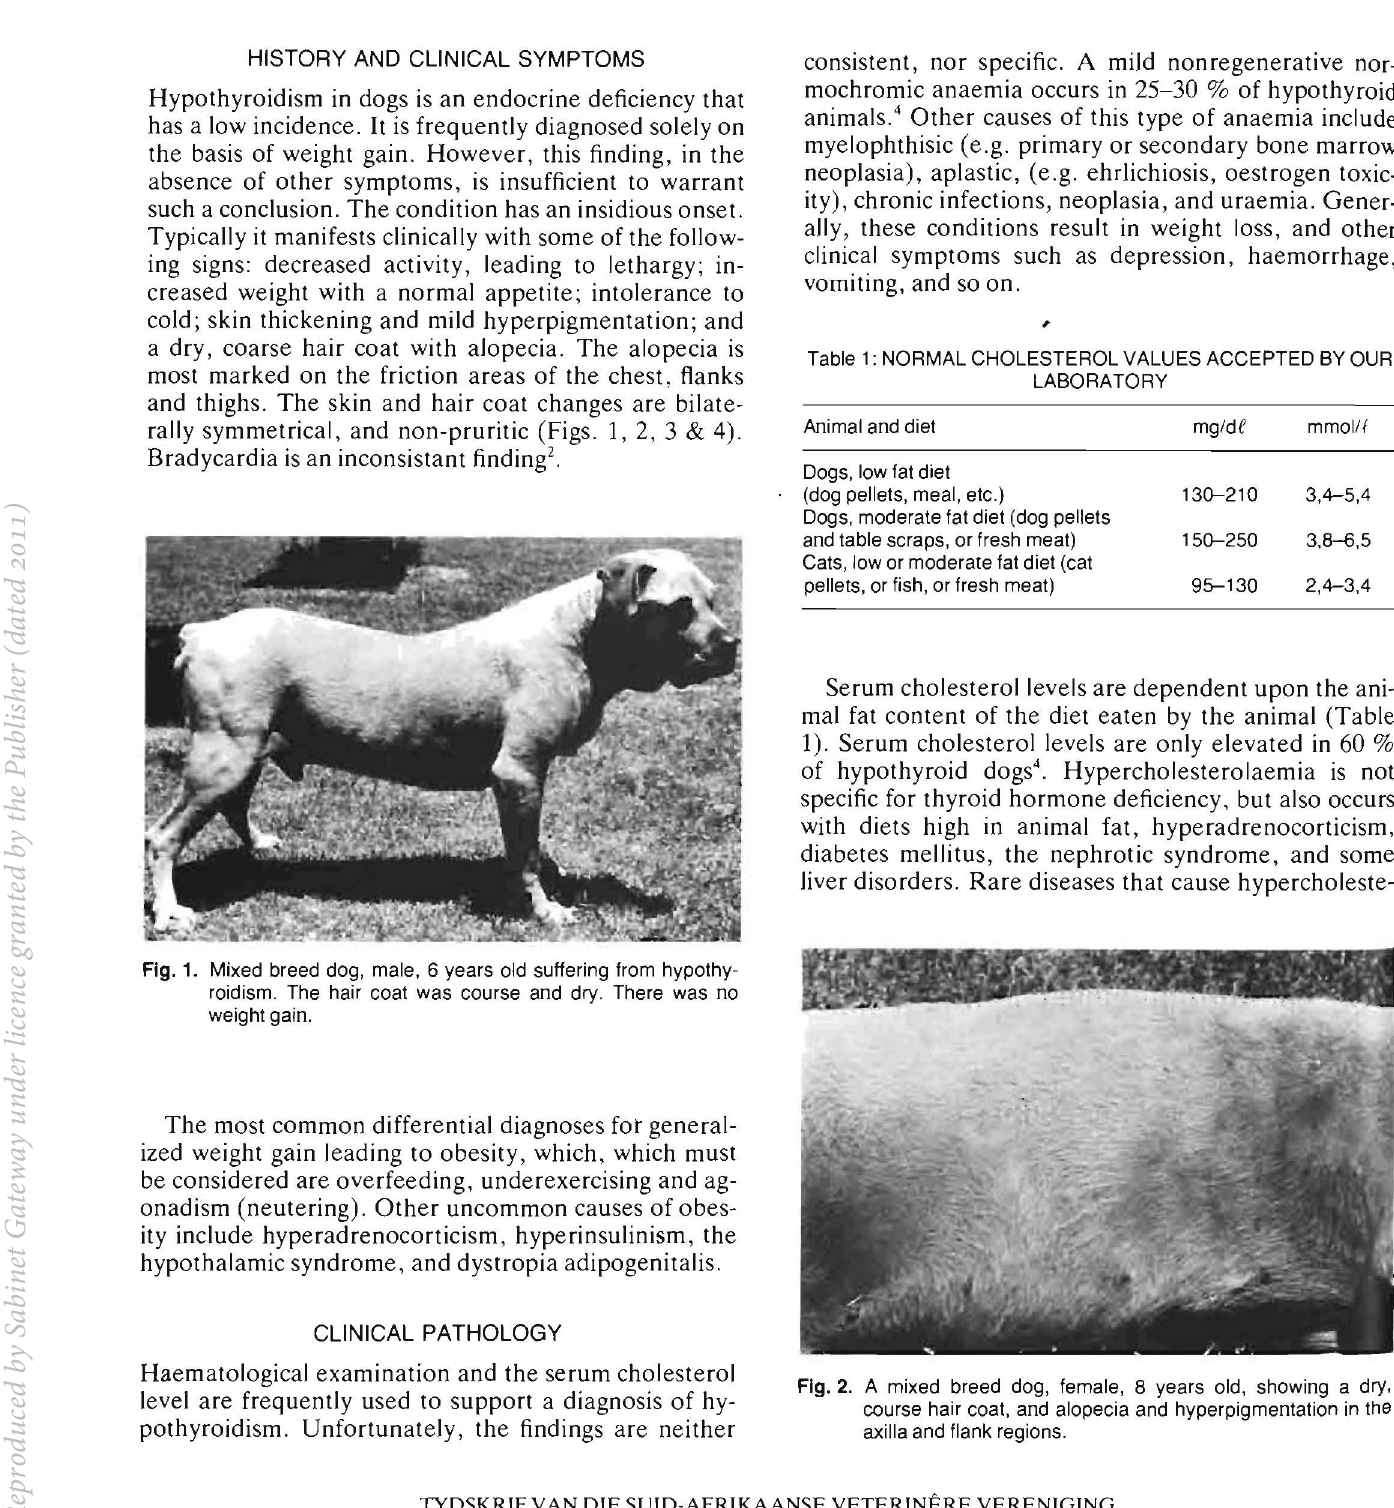
Fig. 1. Mixed breed dog, male, 6 years old suffering from hypothy roidism. The hair coat was course and dry. There was no weight gain.